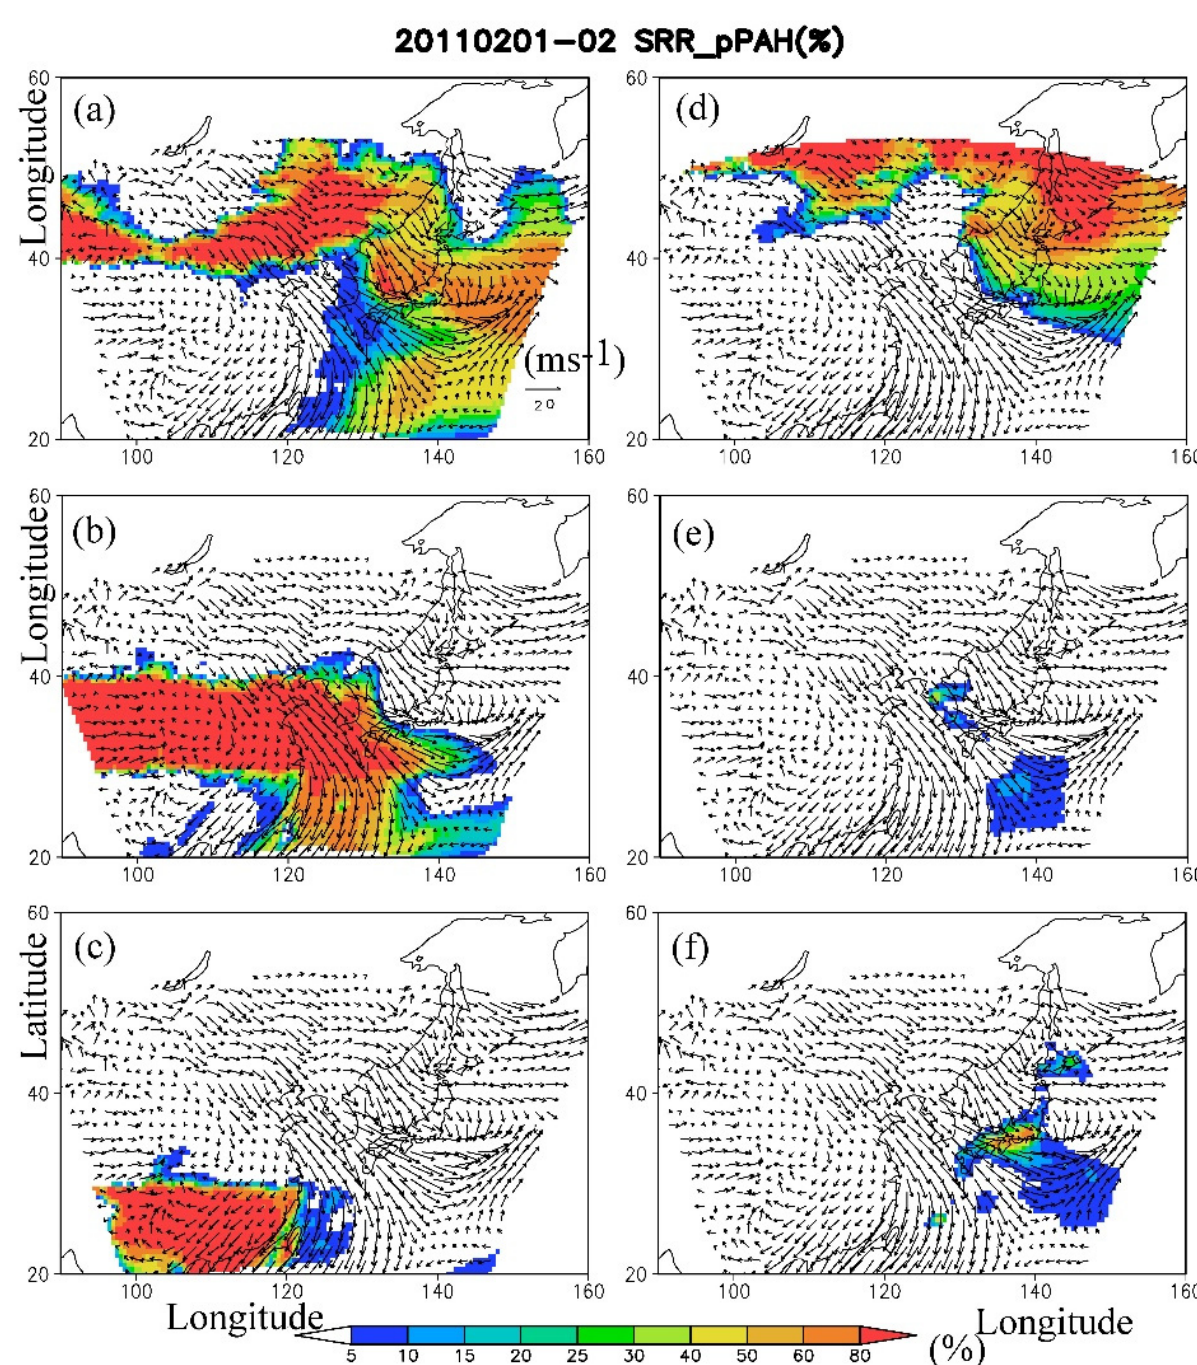
Figure 6. Spatial distributions of the relative contributions (%) to the p-PAH concentration of the six source domains from 1–2 February 2011. ( a ) NCHN, ( b ) CCHN, ( c ) SCHN, ( d ) ERUS, ( e ) SKOR, and ( f )